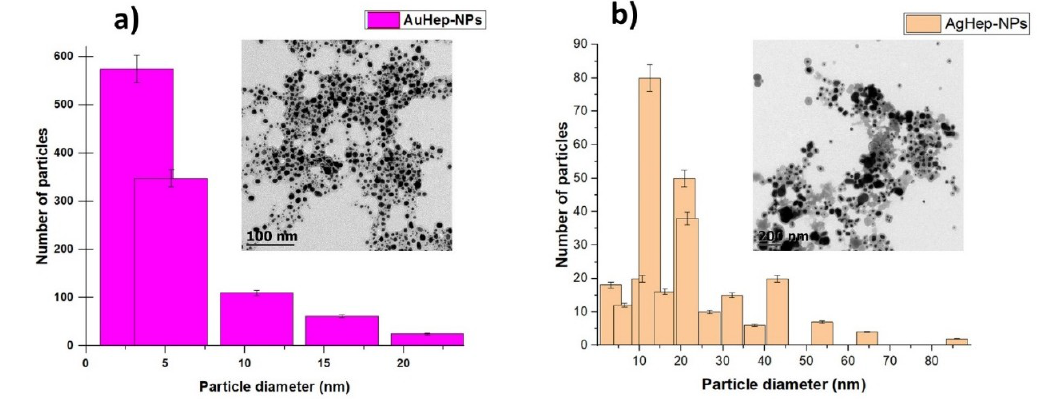
Figure 2. Transmission Electron Microscopy (TEM) micrographs: ( a ) AuHep-NPs and ( b ) AgHep- NPs, showing nanoparticles’ morphology as well as